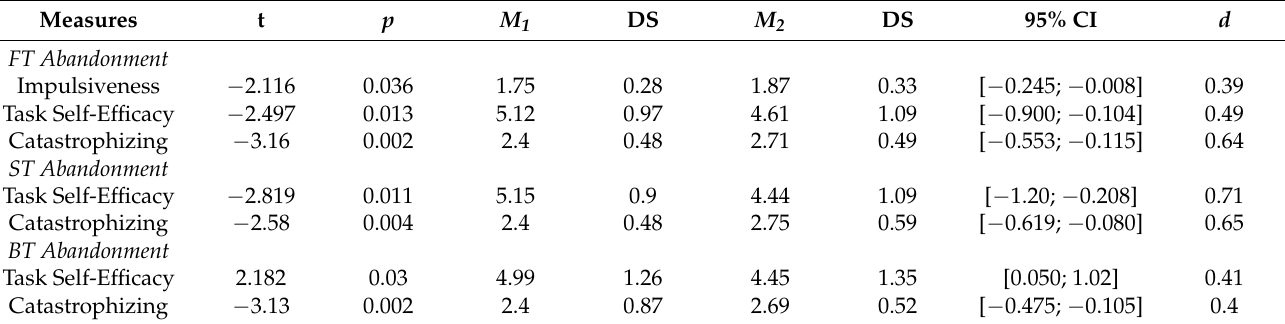
Table 1. Individual differences in experimental abandonments.